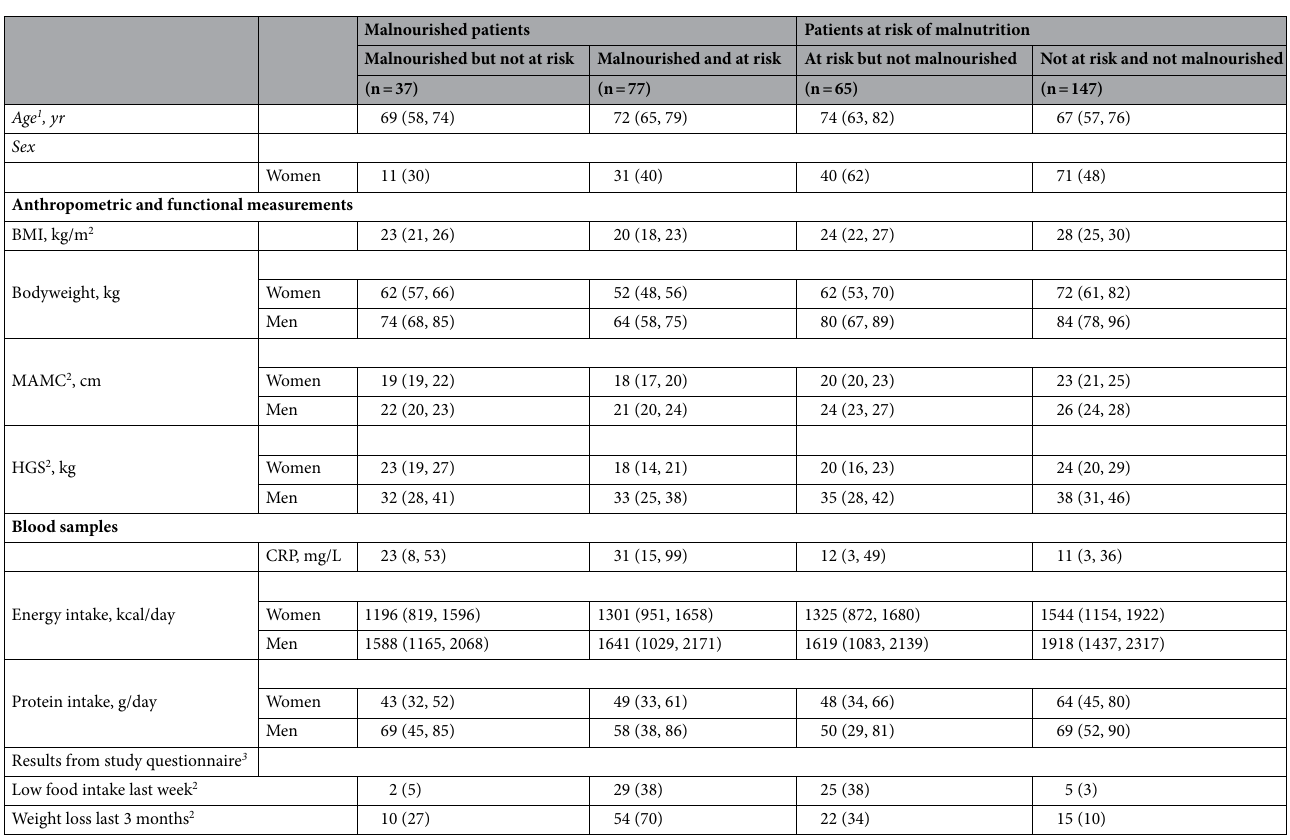
Table 4. Patients’ characteristics according to results of nutritional assessment (GLIM) and nutritional risk screening (NRS2002). Malnutrition was diagnosed by nutritional assessment in 114 patients, of these, 77 were also identified by NRS2002. Malnutrition was not confirmed in 65 patients at risk of malnutrition. For comparison, also those not at risk and not diagnosed with malnutrition are presented. Continuous variables are presented as medians (25th, 75th percentile) and categorical variables are reported as counts (%). BMI, Body mass index; CRP, C-reactive protein; GLIM, Global Leadership Initiative on Malnutrition; HGS, handgrip strength; NRS2002, Nutritional Risk Screening 2002; MAMC, Mid-arm muscle circumference. 1 Age at inclusion. 2 Missing values: n = 305 patients with information on MAMC; n = 304 patients with information on low food intake the last week; n = 312 patients with information on weight loss the last 3 months. 3 Self- reported food intake < 50% of normal during the last week and self-reported weight loss > 5% within past 3 months from a study